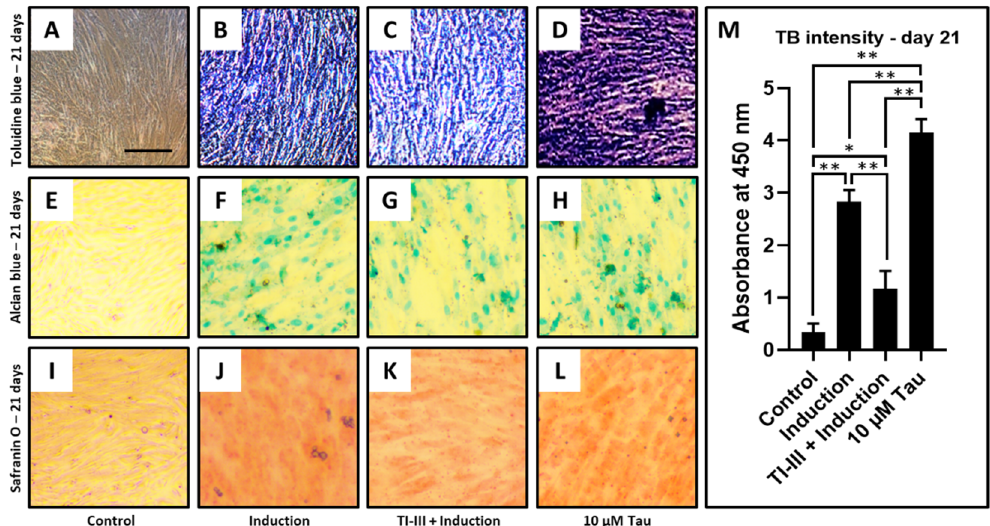
Figure 4. Chondrogenic differentiation of DPSCs and quantification of toluidine blue intensity. Chondrogenic differentiation was induced in DPSCs with and without treatment with telomerase inhibitor and DPSCs treated with taurine alone were assessed for chondrogenesis. Functional staining was done with ( A – D ) toluidine blue, ( E – H ) Alcian blue, and ( I – L ) safranin O. Scale bar = 100 µ m, ( M ) Comparative quantification of toluidine blue intensity day 21. * p < 0.05, ** p < 0.01. Induction: Chondrogenic differentiation, Tau: Taurine, TI-III: Telomerase Inhibitor III, TB: Toluidine blue. Table 7. Toluidine blue (TB) intensity analysis. tion, and 10 μ M taurine treated DPSCs. SOX9, COL2A1, ACAN, and ELN showed upreg-